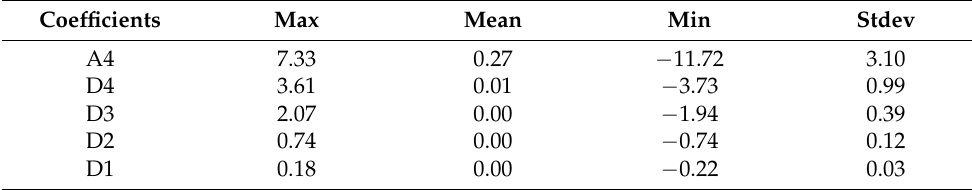
Table 4. Max, mean, min and stdev features (AF).